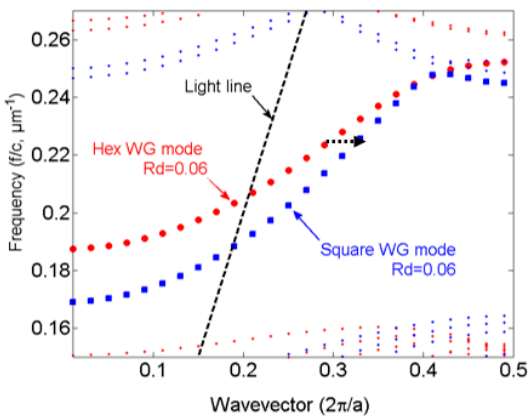
Figure 4. Dispersion diagram of PCWGs with hexagonal lattice (red dot) and square lattice (blue dots), respectively.